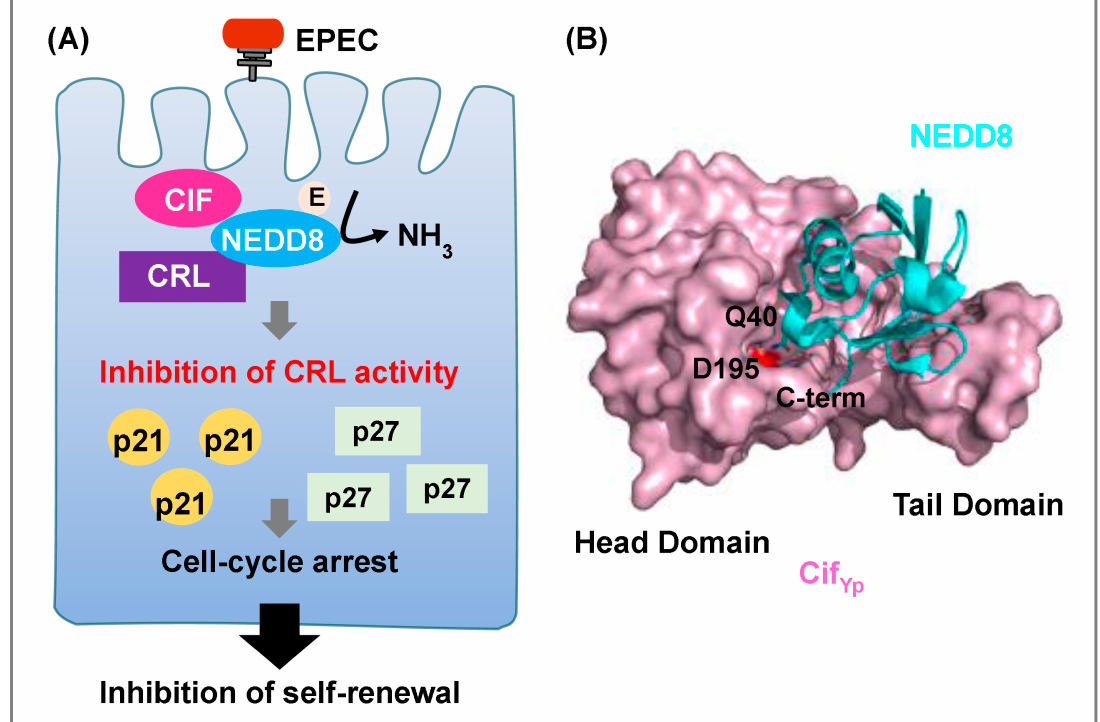
4. Bacterial deamidase Cif family proteins target host UPS. ( A ) The enteropathogenic Escherichia coli (EPEC) effector Cif deamidates NEDD8 to inhibit CRL activity. Deamidation of NEDD8 results in G1 or G2/M cell-cycle arrest via accumulation of the cyclin-dependent kinase inhibitors p21 and p27 in epithelial cells; ( B ) Surface representation of Cif (pink) complex with NEDD8 (cyan) (PDB ID 4F8C). D195 of Cif Yp is shown in red. Q40 of NEDD8 is shown as a stick